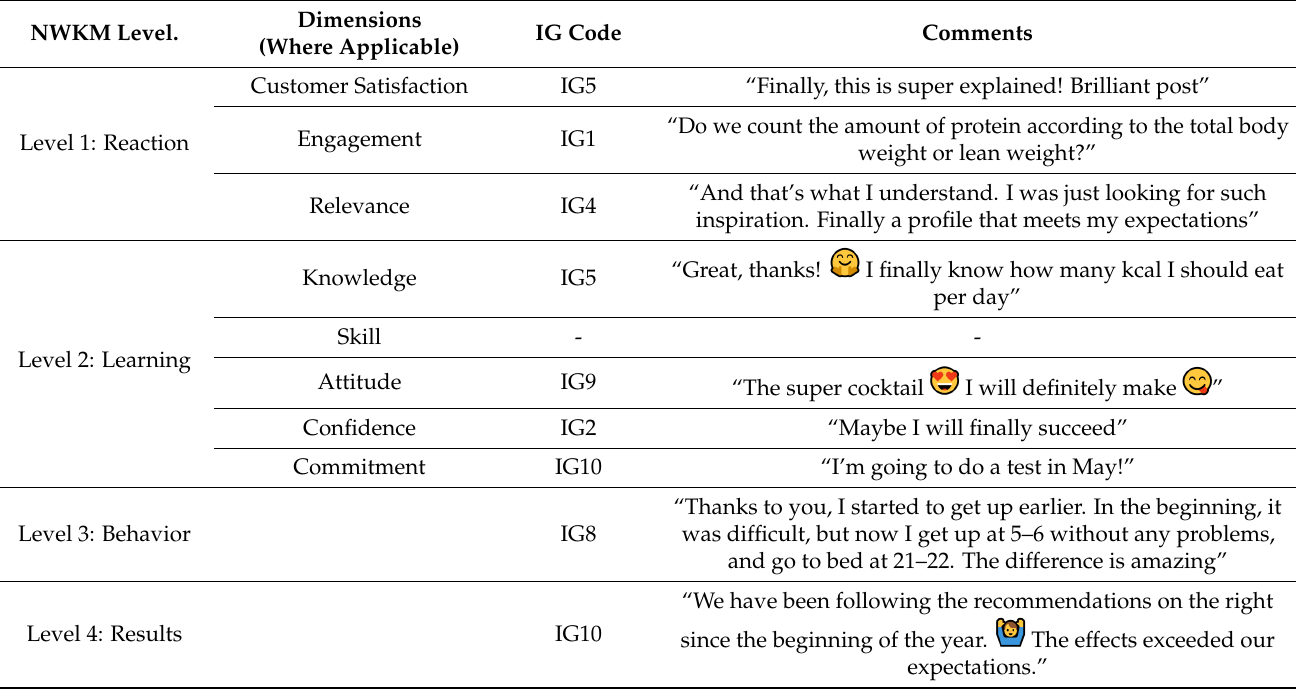
Table 1. The comment evaluation form used during the study with examples. NWKM Level.